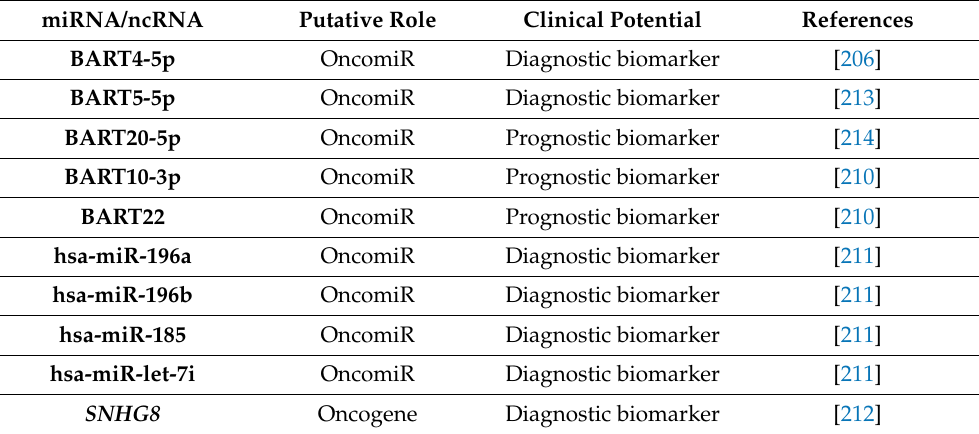
Table 5. miRNAs/lncRNAs in gastric